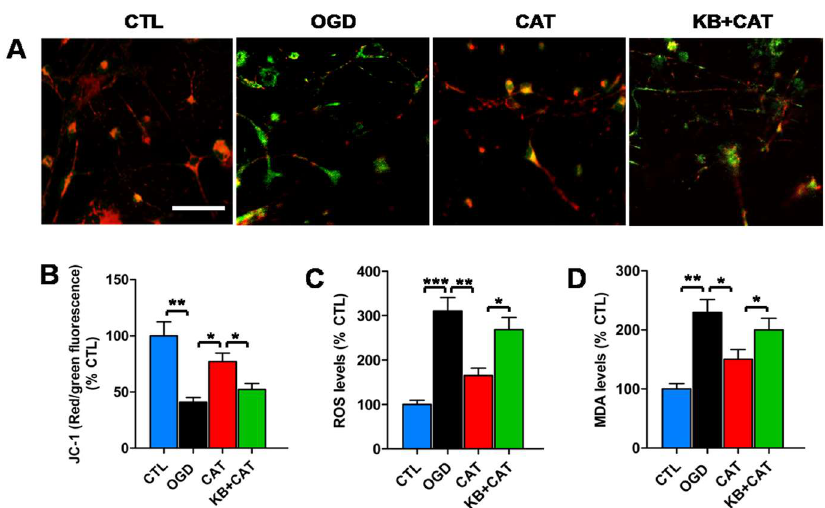
Figure 6. Effects of catalpol on mitochondrial damage in PreOLs under OGD and KB-R7943 treatment. ( A ) Representative JC-1 staining in the CTL, OGD, CAT, and KB+CAT groups. Bar = 25 μm. ( B ) Quantification of the red/green fluorescence ratio in the CTL, OGD, CAT, and KB+CAT groups. The ratio of red/green fluorescence intensity represents the mitochondrial membrane potential. ( C ) Quantification of reactive oxygen species (ROS) levels in the CTL, OGD, CAT, and KB+CAT groups. ( D ) Quantification of malondialdehyde (MDA) levels in the CTL, OGD, CAT, and KB+CAT groups. Data are shown as means ± SEM ( n = 6 in each group). * p < 0.05; ** p < 0.01; *** p < 0.001. To correlate the ERK1/2 signaling pathway with catalpol-mediated protective effects on PreOLs, Western blot analysis was performed for p-ERK1/2 and poly-ADP-ribose polymerase-1 (PARP-1), an ERK1/2 target involved in cell death. The p-ERK1/2 protein levels were low in the CTL group, but they were substantially increased in the OGD group ( p < 0.01), and these increases were effectively prevented by catalpol administration ( p < 0.05). By contrast, co-application of KB-R7943 and catalpol reversed the effect of catalpol on ERK1/2 activation, as indicated by the elevated expression of the p- ERK1/2 protein, which differed significantly from that in the CAT group ( p < 0.05). Similar to p- ERK1/2, PARP-1 protein levels were considerably higher in the OGD group than in the CTL group ( p < 0.01), and catalpol significantly inhibited this elevation ( p < 0.05). Following NCX3 inhibition using KB-R7943, PARP-1 protein levels were significantly increased compared to the CAT group ( p < 0.05) (Figure 7A,B). These data indicate that the ERK1/2 signaling pathway may contribute to the effects of catalpol on PreOLs following OGD-induced intracellular Ca 2+ overload.